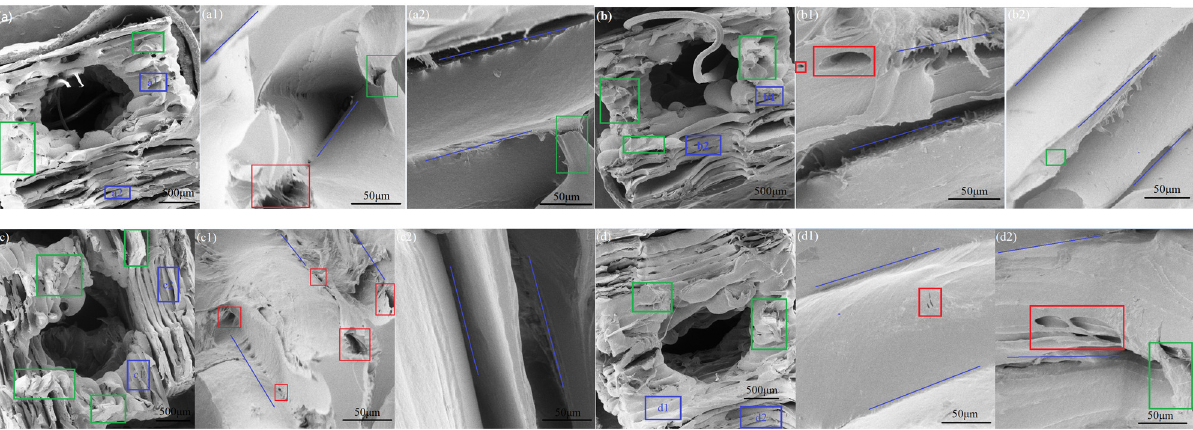
Figure 9: The tensile fractural morphology of PEEK scaffolds with pores gradual between: ( a ) 0.4 and 0.8 mm, ( b ) 0.6 and 1.0 mm, ( c ) 0.8 and 1.2 mm, and ( d ) 1.2 and 2.0 mm; ( a1 ) and ( a2 ) , ( b1 ) and ( b2 ) , ( c1 ) and ( c2 ) , and ( d1 ) and ( d2 ) are the enlargers of the blue rectangles in ( a – d ) ,